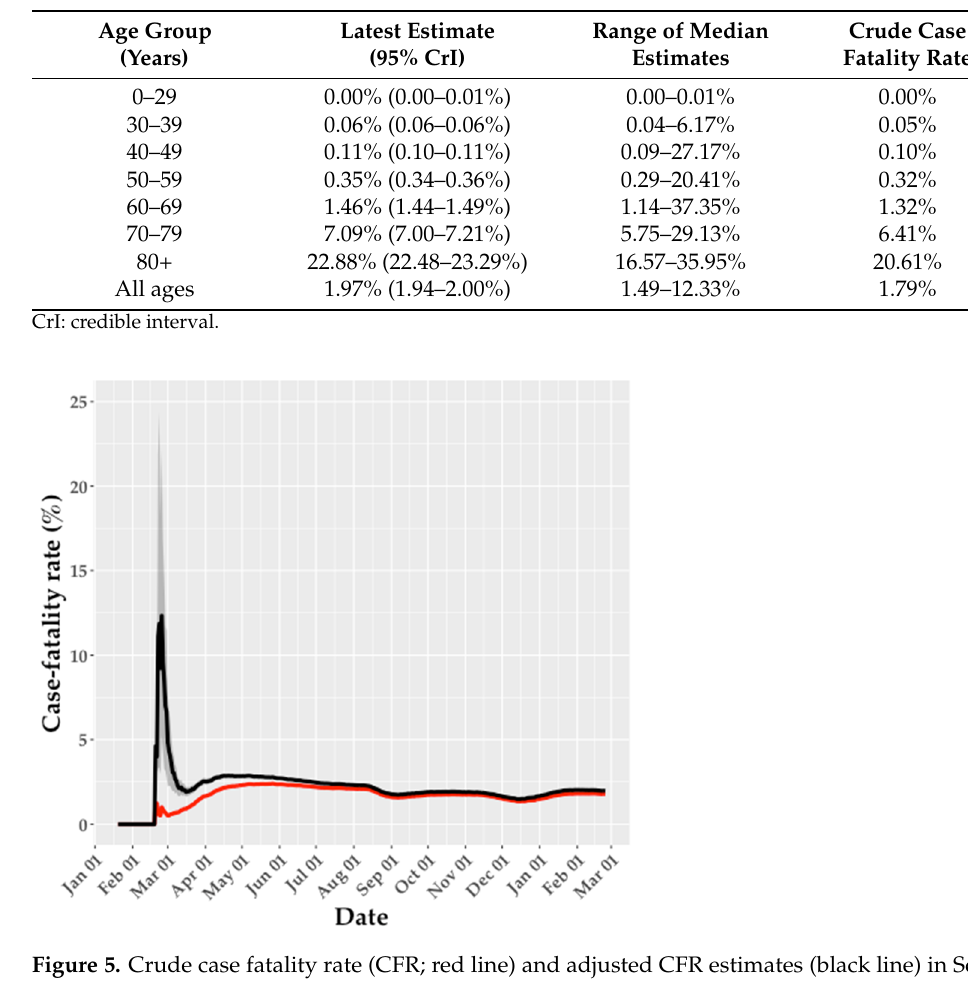
Figure 5. Crude case fatality rate (CFR; red line) and adjusted CFR estimates (black line) in South Korea up to 23 February 2021. The shaded area around the black line illustrates the 95% credible interval (CrI) for the adjusted CFR.